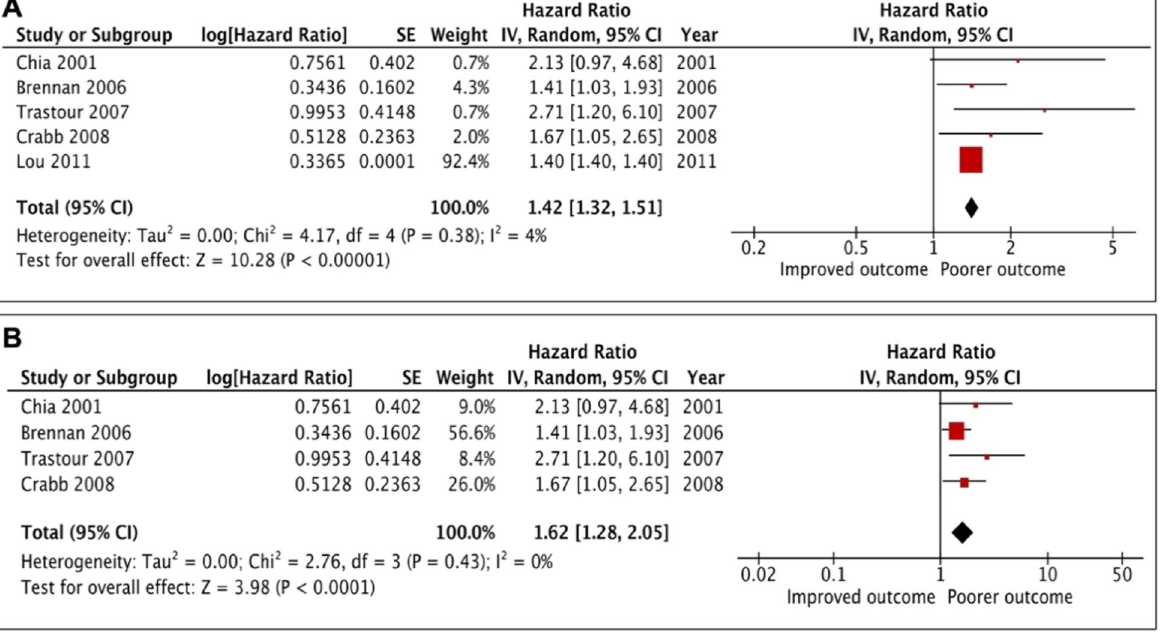
Fig. 2 Forest plot for the relationship between CAIX expression and recurrence free survival in breast cancer patients. Including Lou’s study [ A ], after excluding Lou’s study [ B